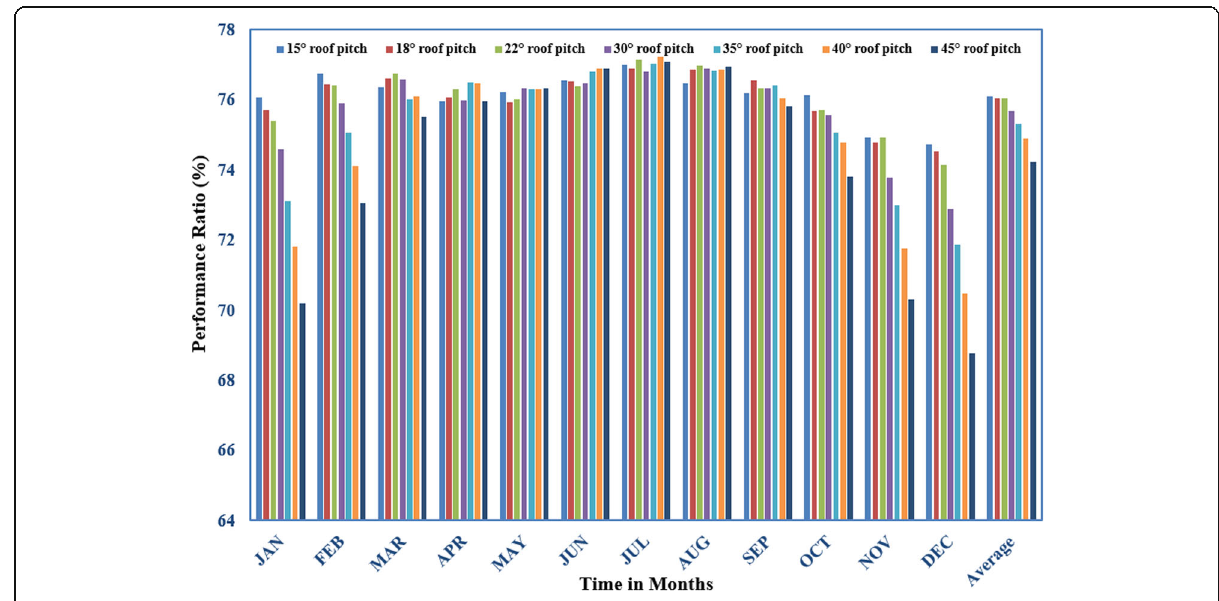
Fig. 8 Performance ratio of pitched roof BIPV power